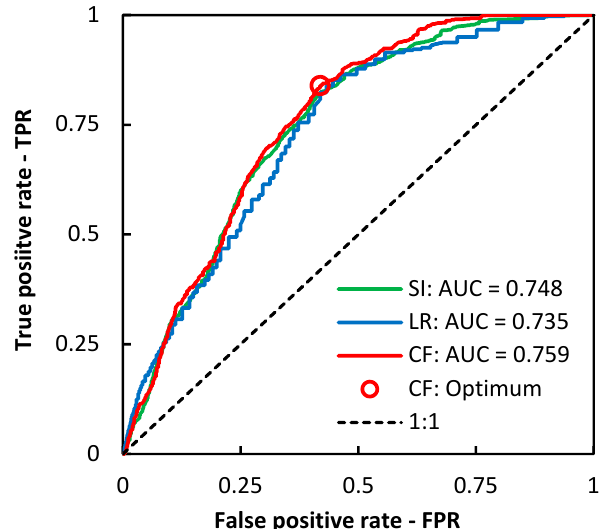
Figure 5. Receiver operating characteristic (ROC) curves and area under the curve (AUC) values showing the accuracy of the models for predicting landslide susceptibility (SI: statistical index model, LR: logistic regression model, CF: certainty factor model) and the optimum threshold point for the CF model.